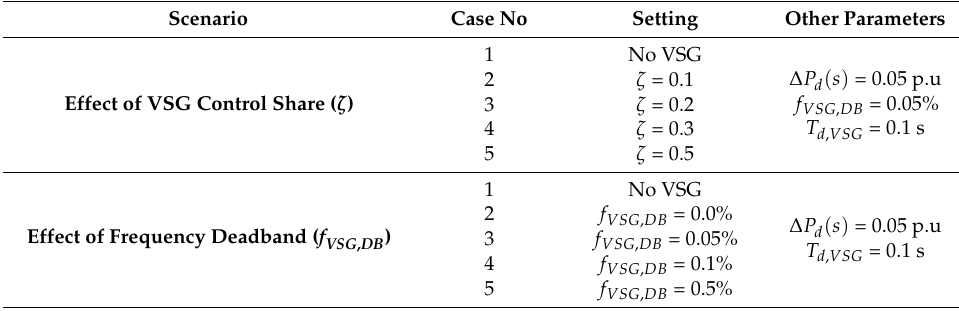
Table 3. VSG control: simulation scenarios and parameter setting.